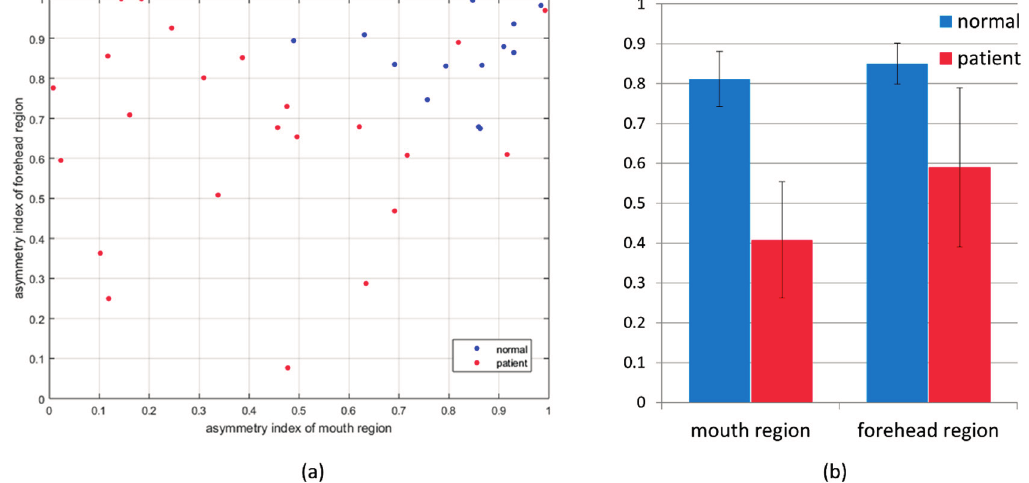
Figure 6. Displacements of mouth corner points during smile movement. Upper graph shows displacement of a patient. Lower graph shows displacement of a normal subject.